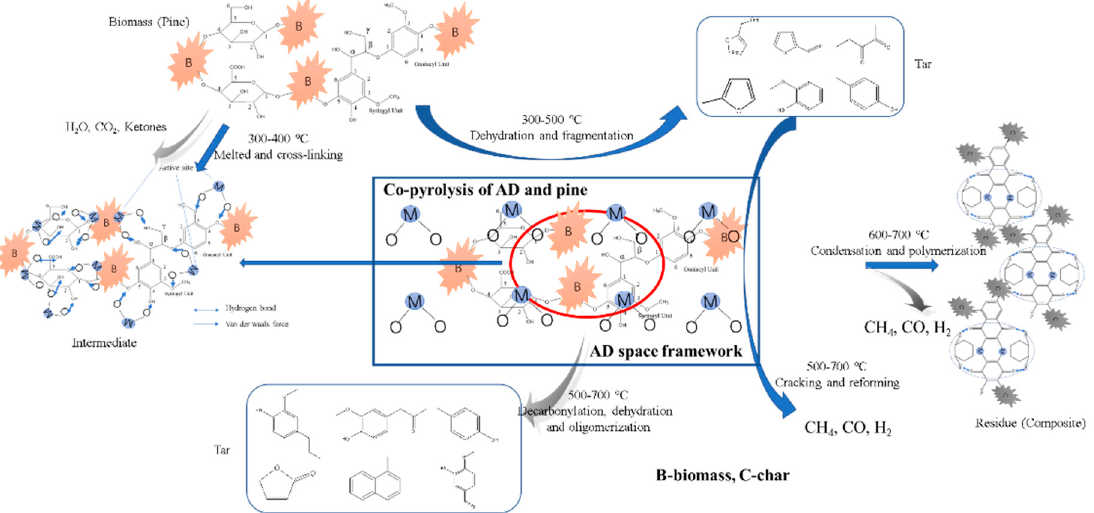
Figure 7. Proposed reaction pathway of catalytic pyrolysis on AD. Tar compositions from fixed bed pyrolysis at 500 and 700 °C were analyzed by GC-MS and are shown in Figure 8.